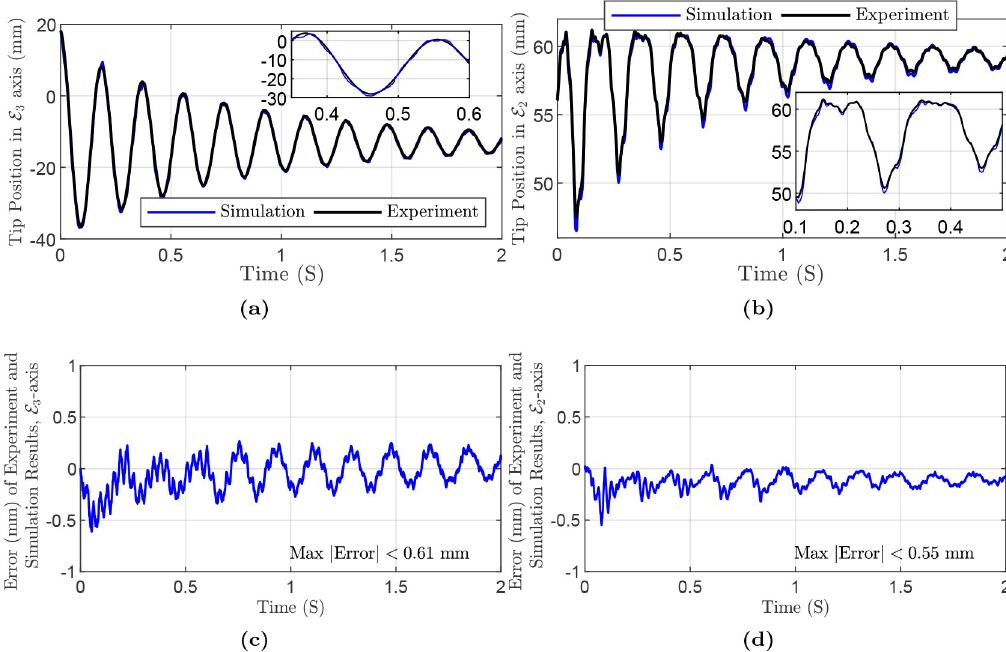
Fig 11. Simulation and experiment results of Polydimethylsiloxane (PDMS) rod with an embedded magnet at the tip, planar experiment: (a) Tip Position in E -axis direction. Inset highlights the results in a small time range. (b) Tip Position in E 3 direction. (c) Error in E -axis direction. (d) Error in E -axis direction. 3 2